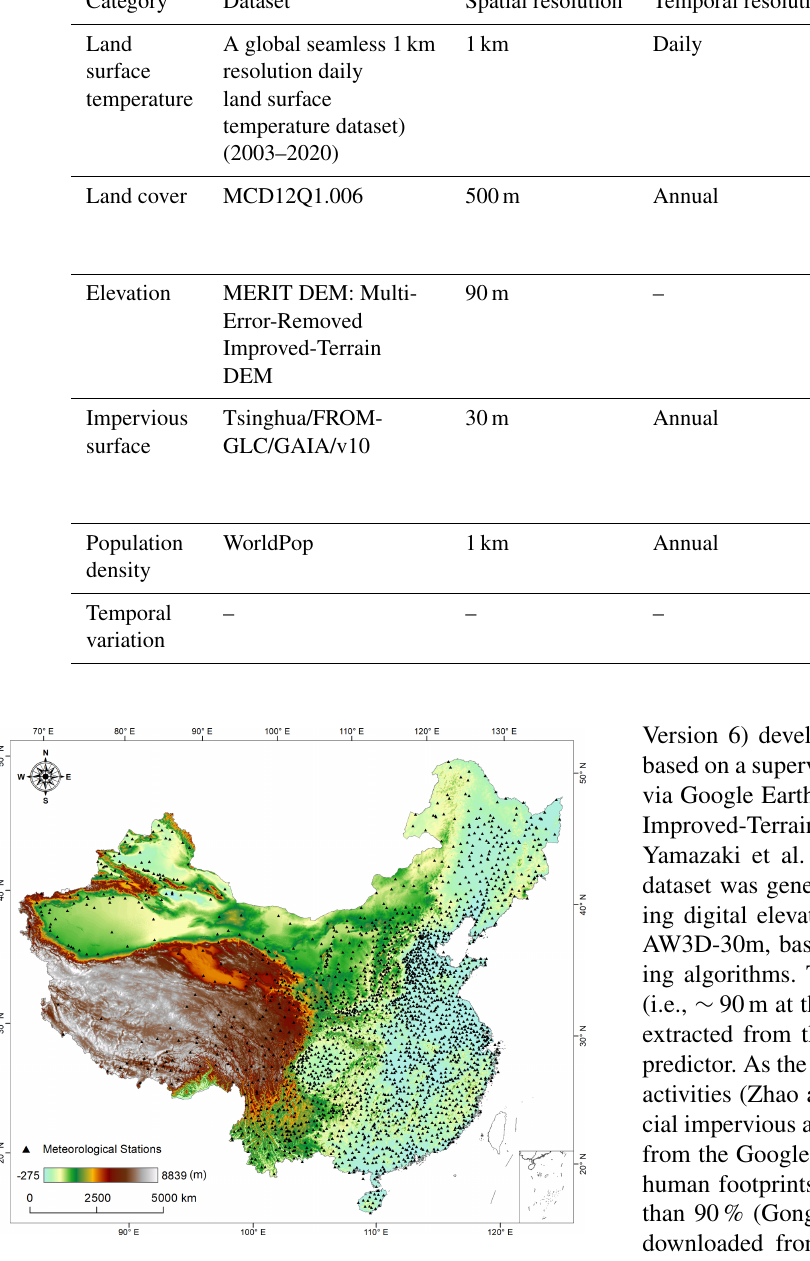
Figure 1. Spatial distribution of meteorological stations in the mainland of China, with color shadings indicating the elevation in